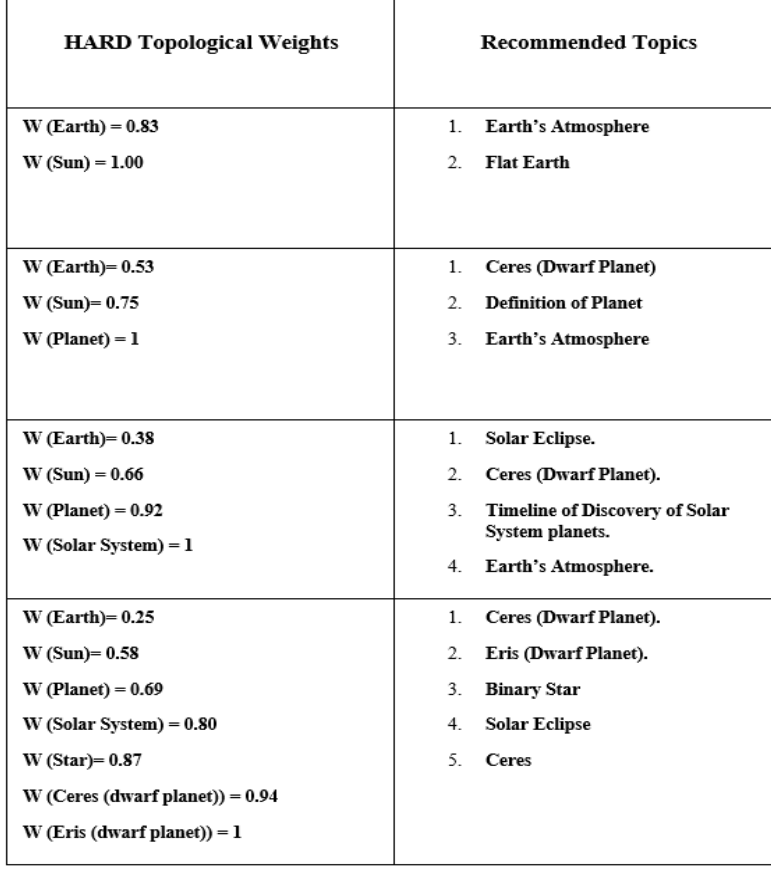
Fig. 3. Illustration of how TNG structural weights change the learner interest model and ac- cordingly the personalized list of recommended